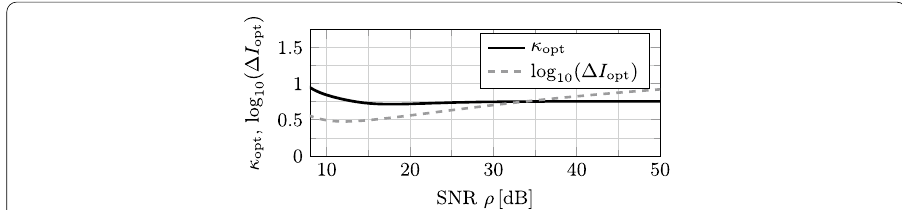
W (cid:31) − 1 over the SNR and corresponding ratio C AWGN / I ′ Fig. 6 Optimal ratio κ = The value of κ that minimizes the loss w.r.t. the AWGN-capacity is approximately 0.75 for most of the mid-to-high SNR